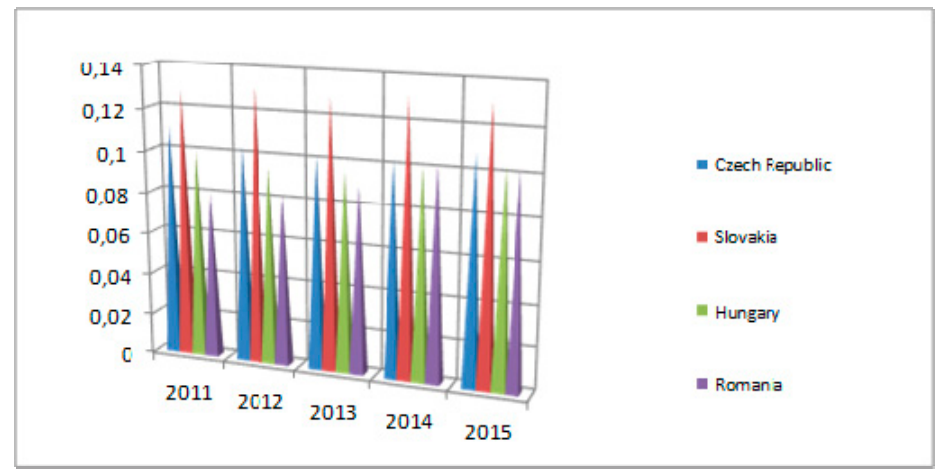
Figure 1. Electricity prices for industry in EUR/kWh. Source: authors’ representation based on information extracted from Eurostat, 2015 [23].